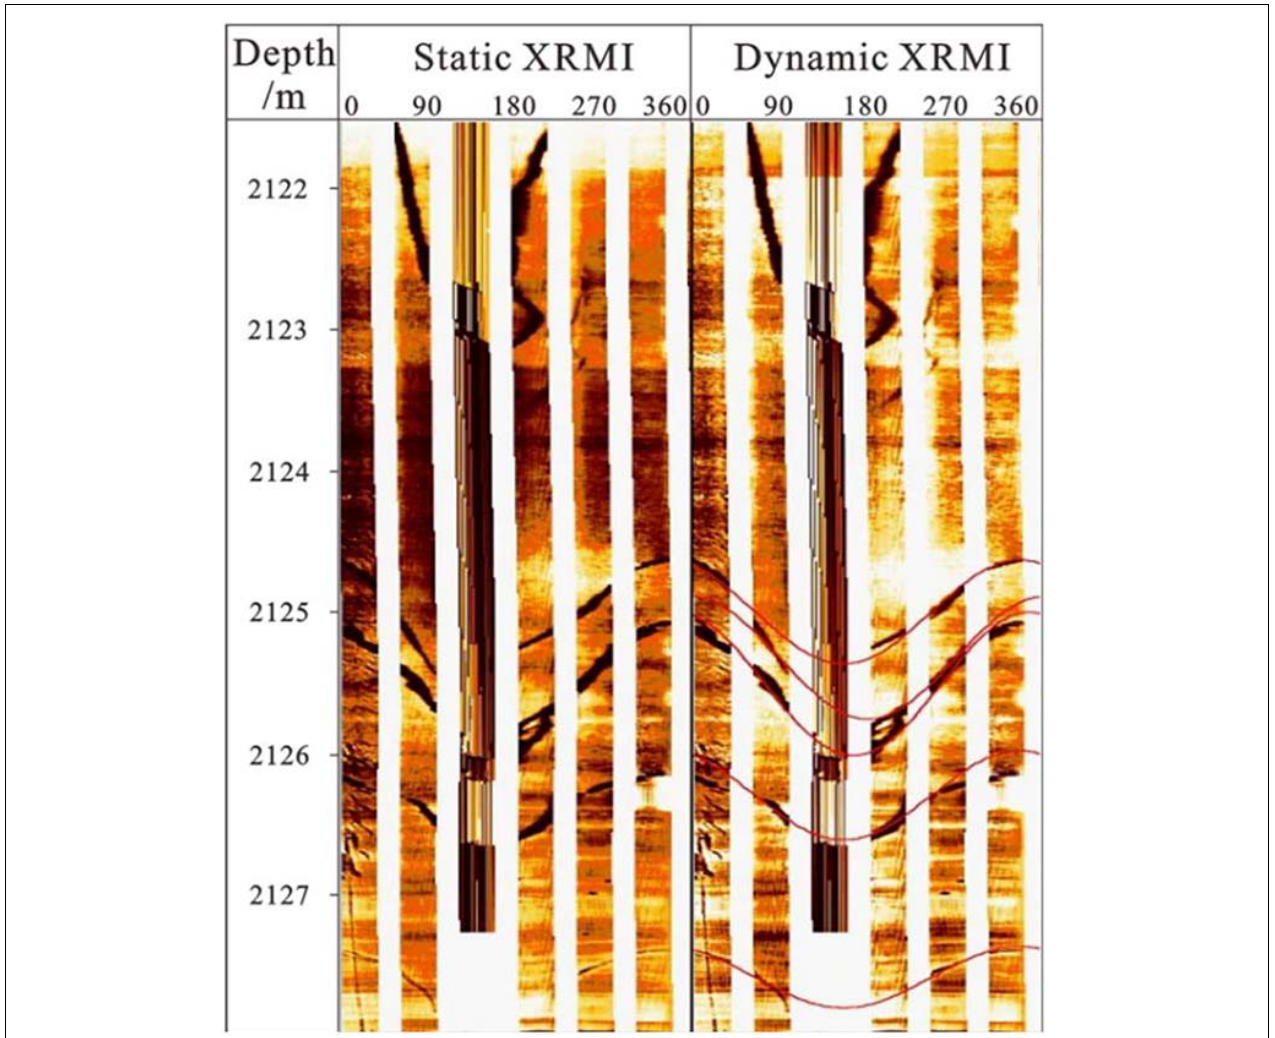
FIGURE 7 | Fractures detected by micro-resistivity imaging log in the Well H5. See Figure 1 for the location of Well